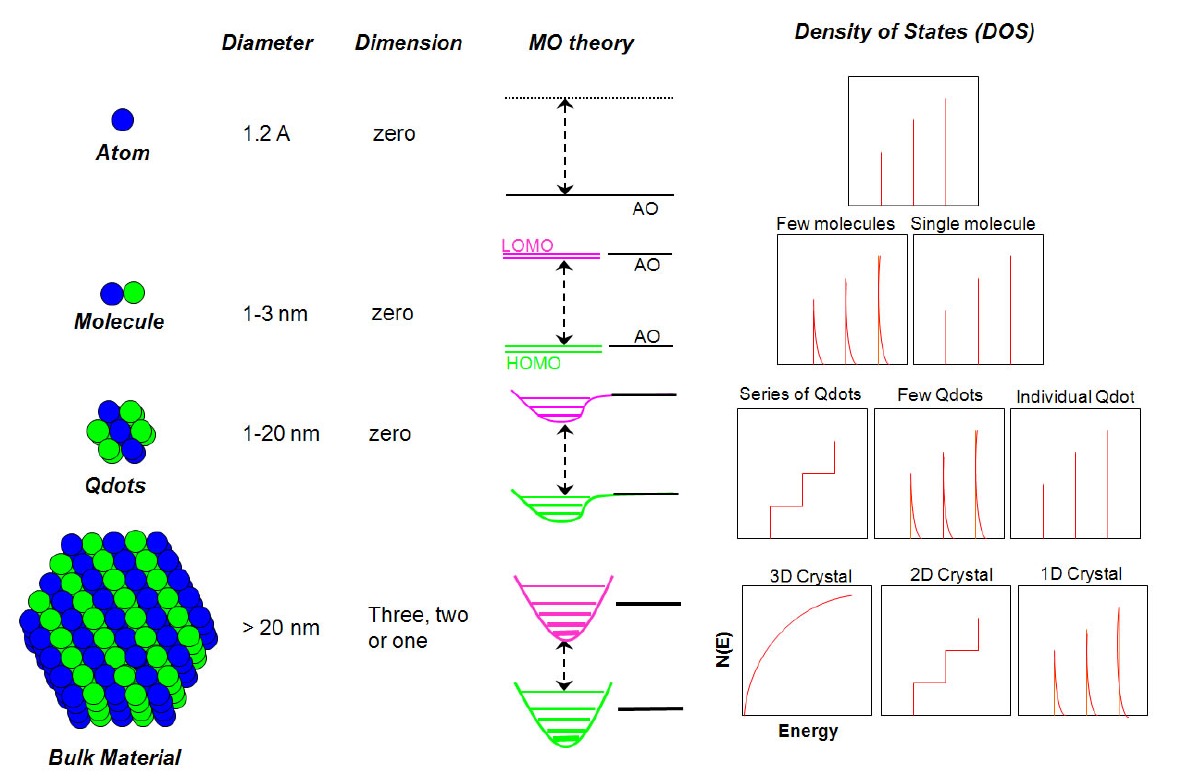
Figure 2. Schematic illustration of the changes of the density of quantum states (DOS) with changes in the number of atoms in materials (MO: molecular orbital; HOMO: highest occupied MO; LUMO: lowest unoccupied MO; AO: atomic orbital)